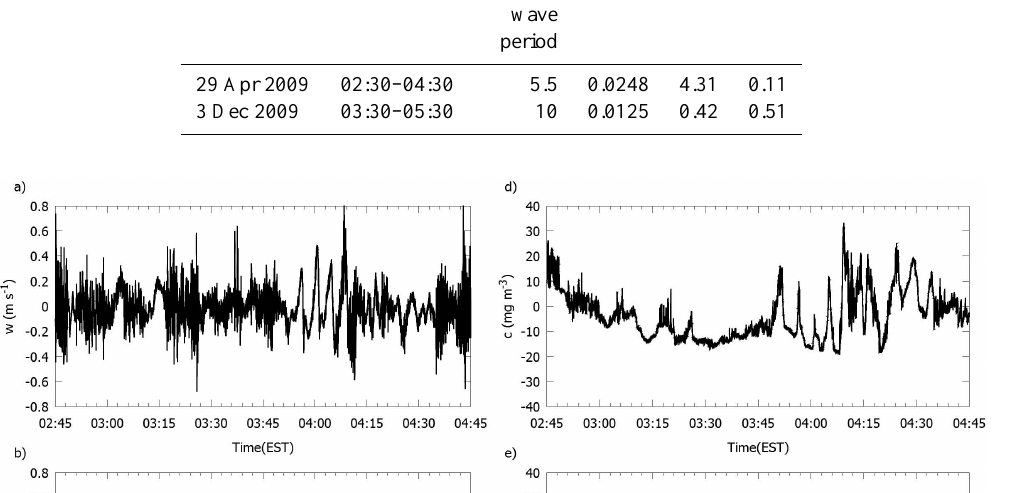
Table 2. Characterization of wave events and atmospheric conditions for the two case study nights including the duration of the wave event, the average wave period (min), the Brunt–Väisälä frequency ( N ), the gradient Richardson number ( Ri ), and the friction velocity ( u ∗ ). Note that the friction velocity ( u ∗ ) is the ensemble 30min average calculated over the duration of wave event at the 34m level without filtering the wave signal.